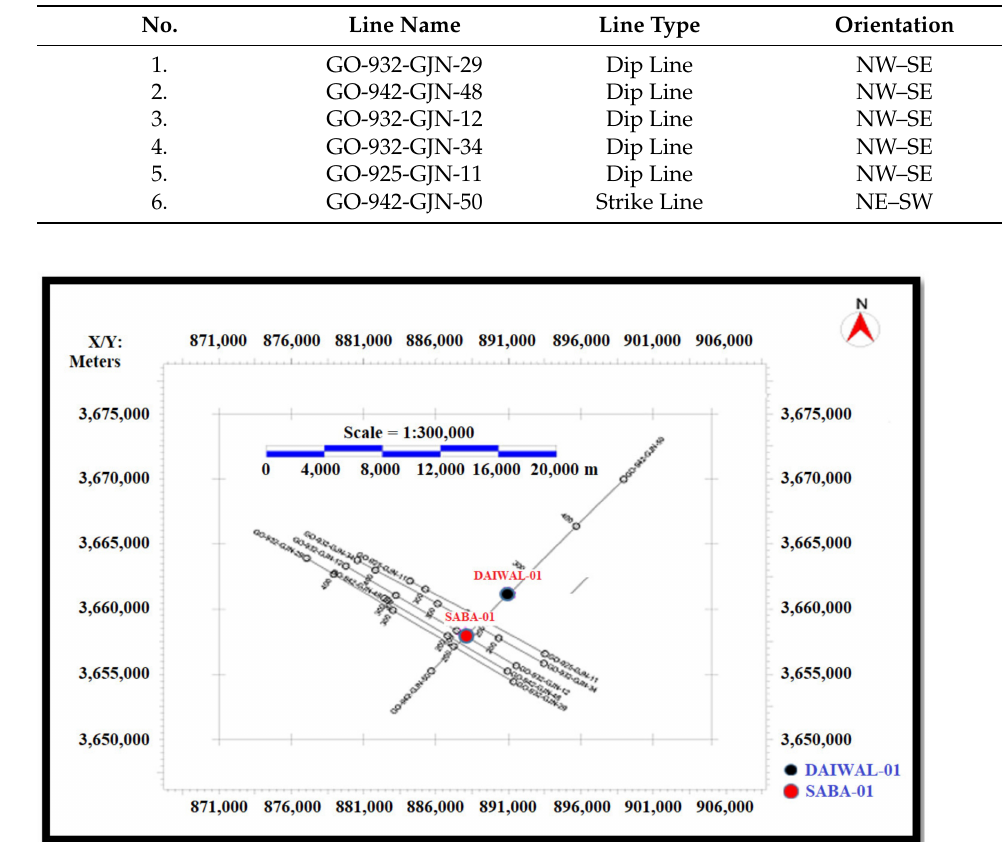
Figure 3. Base map of the Rajian area showing Saba-01 and Daiwal-01